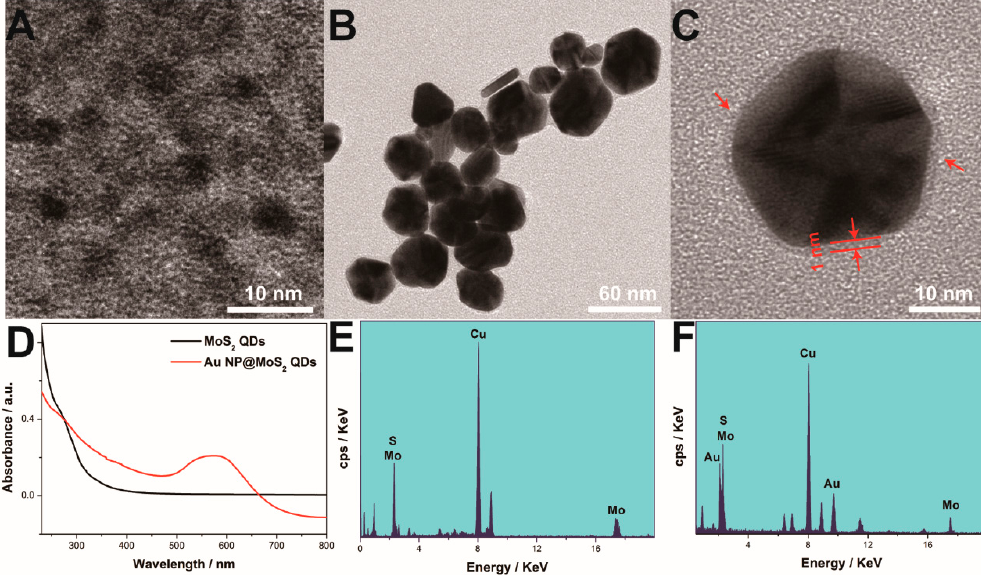
Figure 1. TEM images of MoS 2 QDs ( A ) and Au NP@ MoS 2 QDs at ( B ) low magnification as well as ( C ) high magnification (The red arrows pointed to the shells of the hybrids). UV-Vis spectra of MoS 2 QDs and Au NP@ MoS 2 QDs ( D ). EDX spectra of MoS 2 QDs ( E ) and Au NP@ MoS 2 QDs ( F ).